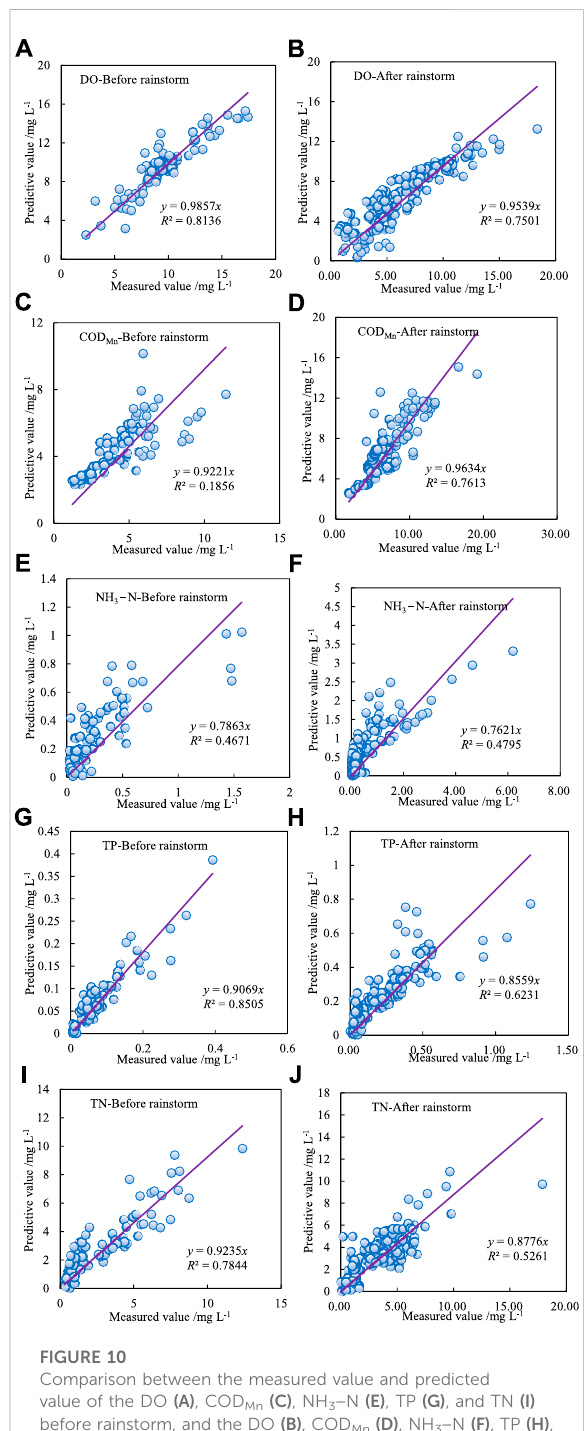
FIGURE 10 Comparison between the measured value and predicted value of the DO (A) , COD Mn (C) , NH 3 − N (E) , TP (G) , and TN (I) before rainstorm, and the DO (B) , COD Mn (D) , NH 3 − N (F) , TP (H) , and TN (J) before rainstorm. The functional relationships between each principal component and water pollutants were established, and the water pollutants were predicted before and after the